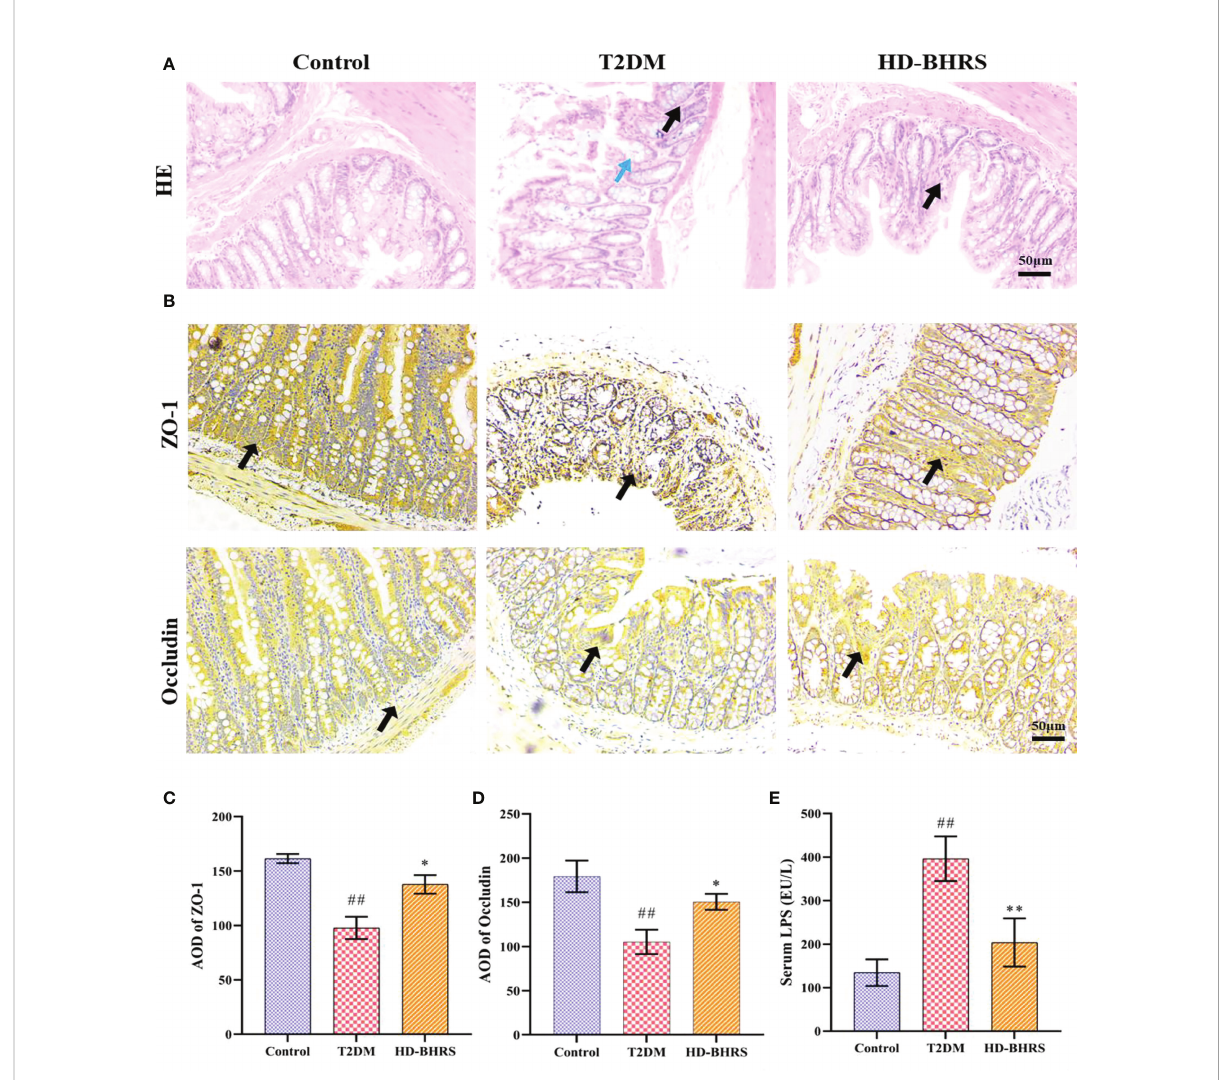
FIGURE 3 BHRS treatment reduced the pathological changes of colon and increased the expression tight junction proteins (ZO-1 and Occludin) in colon and decreased the level of lipopolysaccharide (LPS) in serum. (A) HE staining indicated that the pathological changes of colon (Black arrows indicated the in fi ltration of in fl ammatory cells, blue arrows indicated the impaired structure of colonic epithelial cell) (200×). (B – D) Immunohistochemistry was used to analysis the expression of ZO-1 and Occludin in colon (200×) and the average optical density (AOD) of positive area was calculated using Image Pro Plus 6.0. (E) The LPS level in serum was tested using enzyme linked immunosorbent assay (ELISA). ## : p < 0.01 as compared to the control group; *: p < 0.05 as compared to the T2DM group; **: p < 0.01 as compared to the T2DM